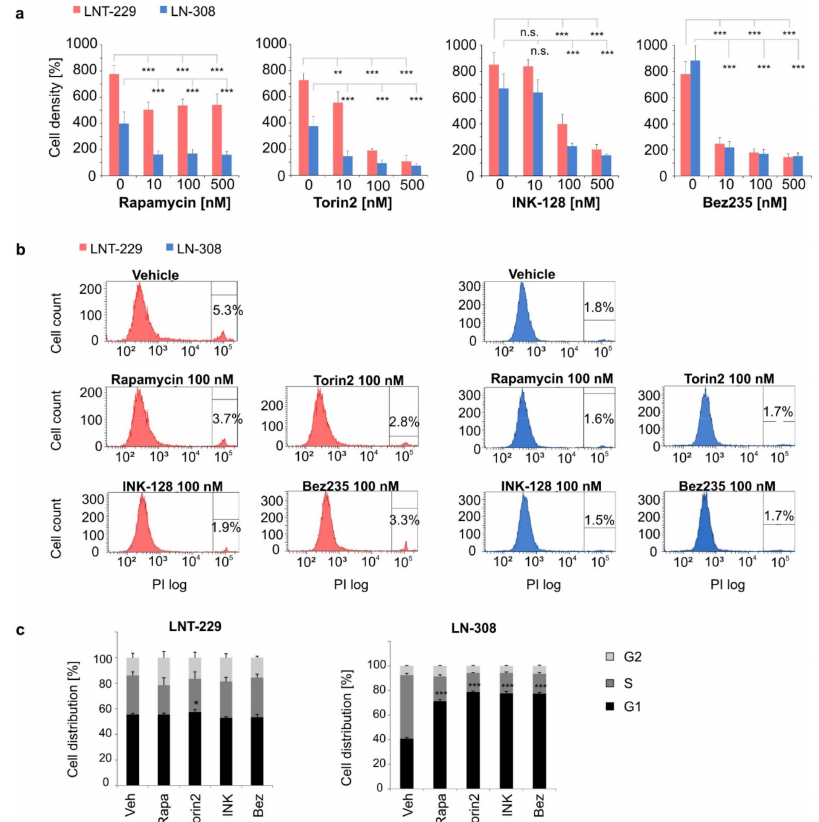
Figure 2. Inhibition of mTORC1 and 2 reduces glioma cell growth. ( a ) LNT-229 and LN-308 cells were incubated in medium containing 10% FCS and treated with rapamycin, torin2, INK-128 or NVP-Bez235 at indicated concentrations for 72 h. Cell density was analyzed by crystal violet staining. Depicted values are normalized to cell density at the beginning of treatment ( n = 3, mean ± S.D.; ** p < 0.01, *** p < 0.001, n.s. = not significant). ( b ) Cytotoxicity of the indicated inhibitor was assessed by propidium iodide (PI) staining and consecutive FACS analysis after incubation for 72 h as described in ( a ) (one representative analysis of n = 3). ( c ) For cell cycle analysis, LN308 or LNT-229 cells were treated with the indicated mTOR inhibitor for 24 h (100 nM rapamycin, 100 nM torin2, 100 nM INK-128 or 10 nM NVP-Bez235). DNA content as a marker of cell cycle phase was measured by PI staining after permeabilization using flow cytometry. The depicted values correspond to the quantification of relative cell cycle phase distribution ( n = 3, mean ± S.D., * p < 0.05, *** p < 0.001). Characteristic mutations of LN-308, LNT-229, G55 and T98G glioma cell lines. IDH1 = isocitrate dehydrogenase 1; MGMT = O -6-methylguanine-DNA methyltransferase gene promoter; PTEN = phosphatase and tensin homolog; WT = wildtype. Cell Line